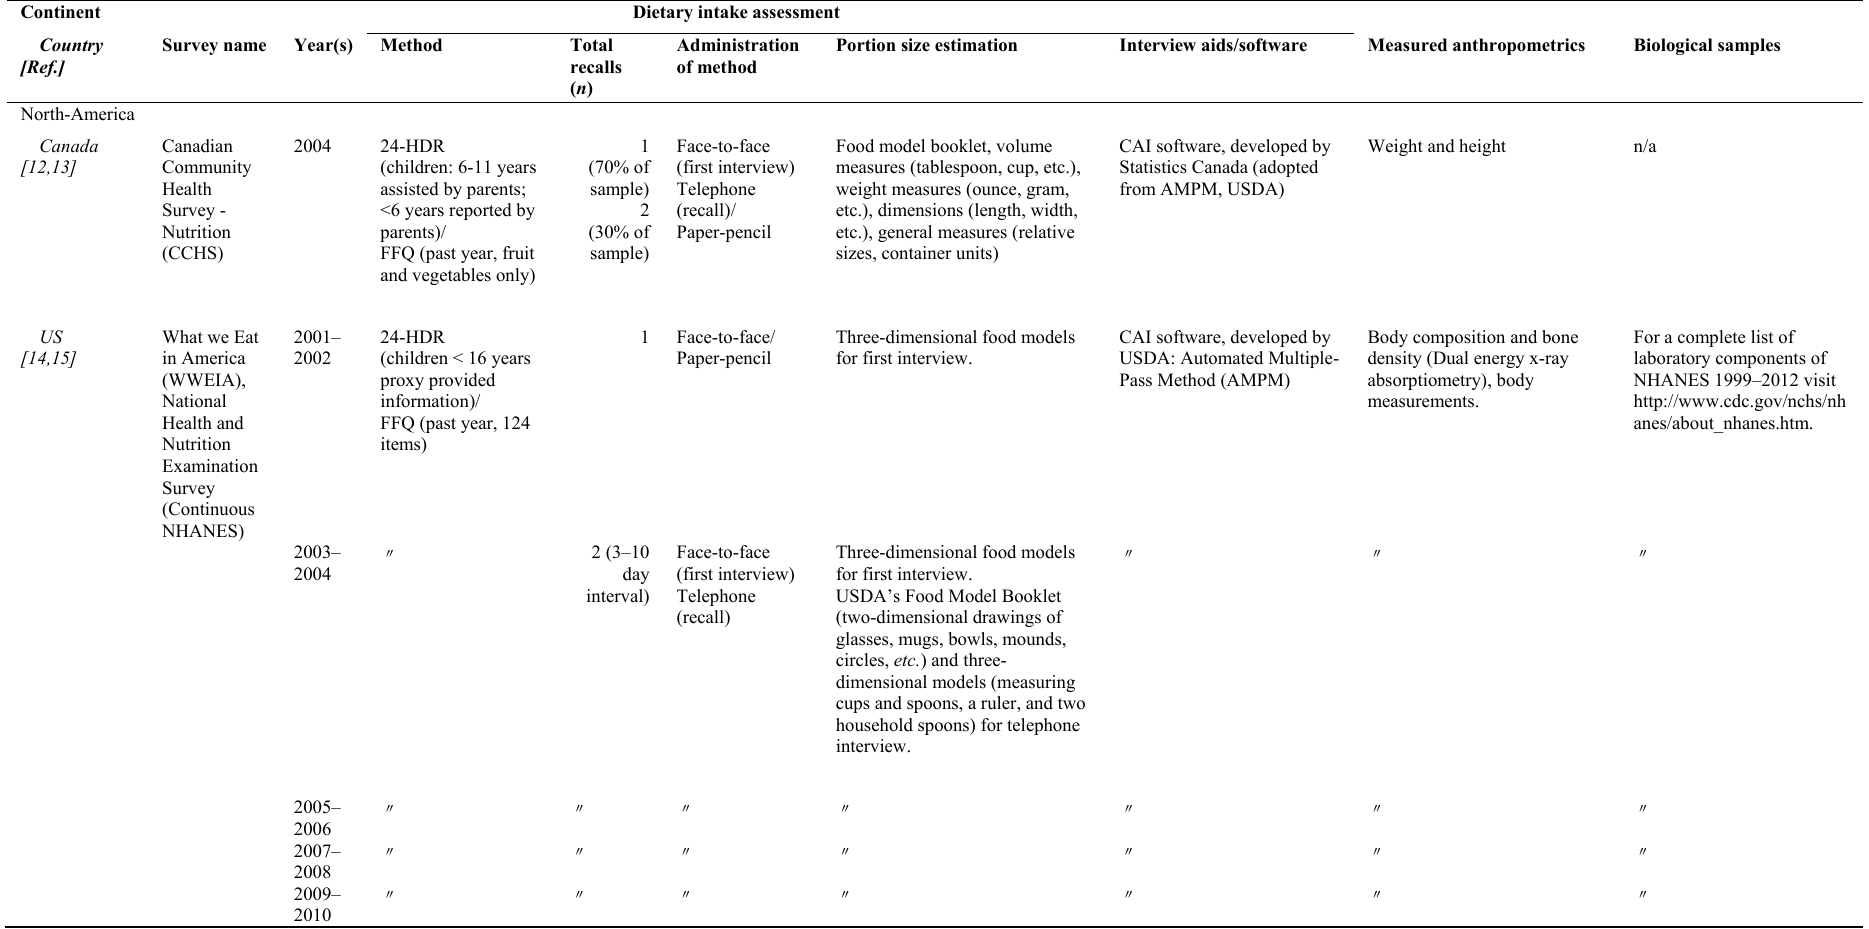
Table 3. Dietary intake and other assessments of national nutrition surveys per